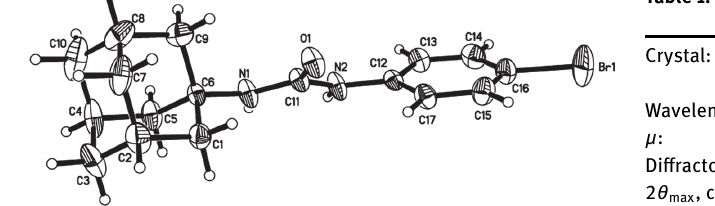
Table 1: Data collection and